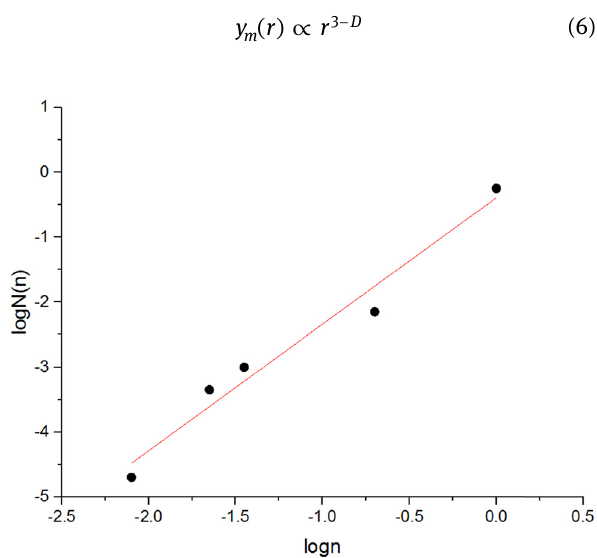
Figure 2: Double logarithmic fi tting of theoretical DSP fractal dimension